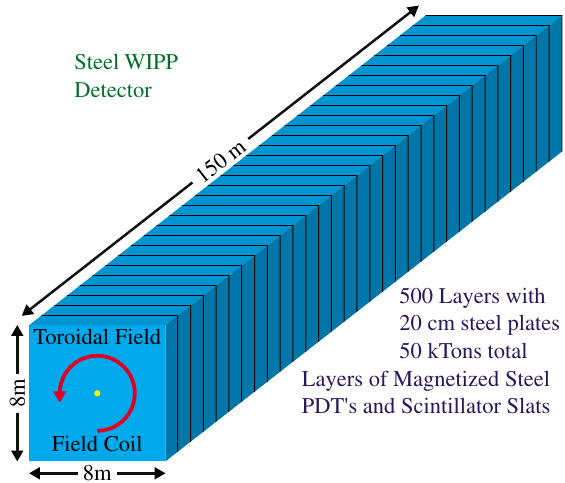
FIG. 30. (Color) Block schematic of the UNO detector, includ- ing initial design